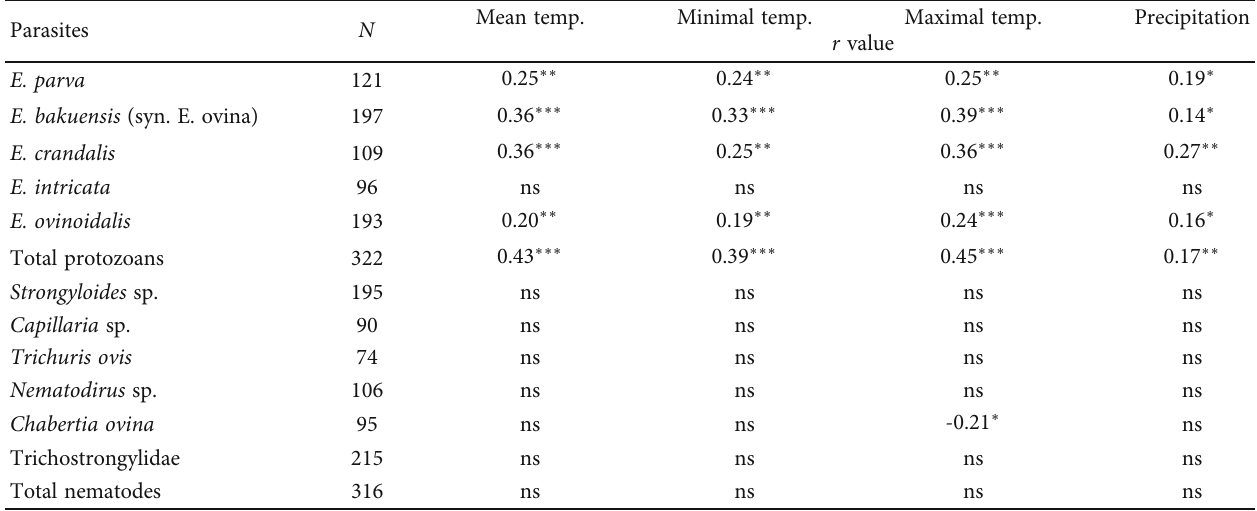
Table 6: The results of the correlation analysis (Spearman ’ s rank-order test) between the intensity of infection and climatic parameters. Mean temp. Minimal temp. Maximal temp. Precipitation Parasites N r value